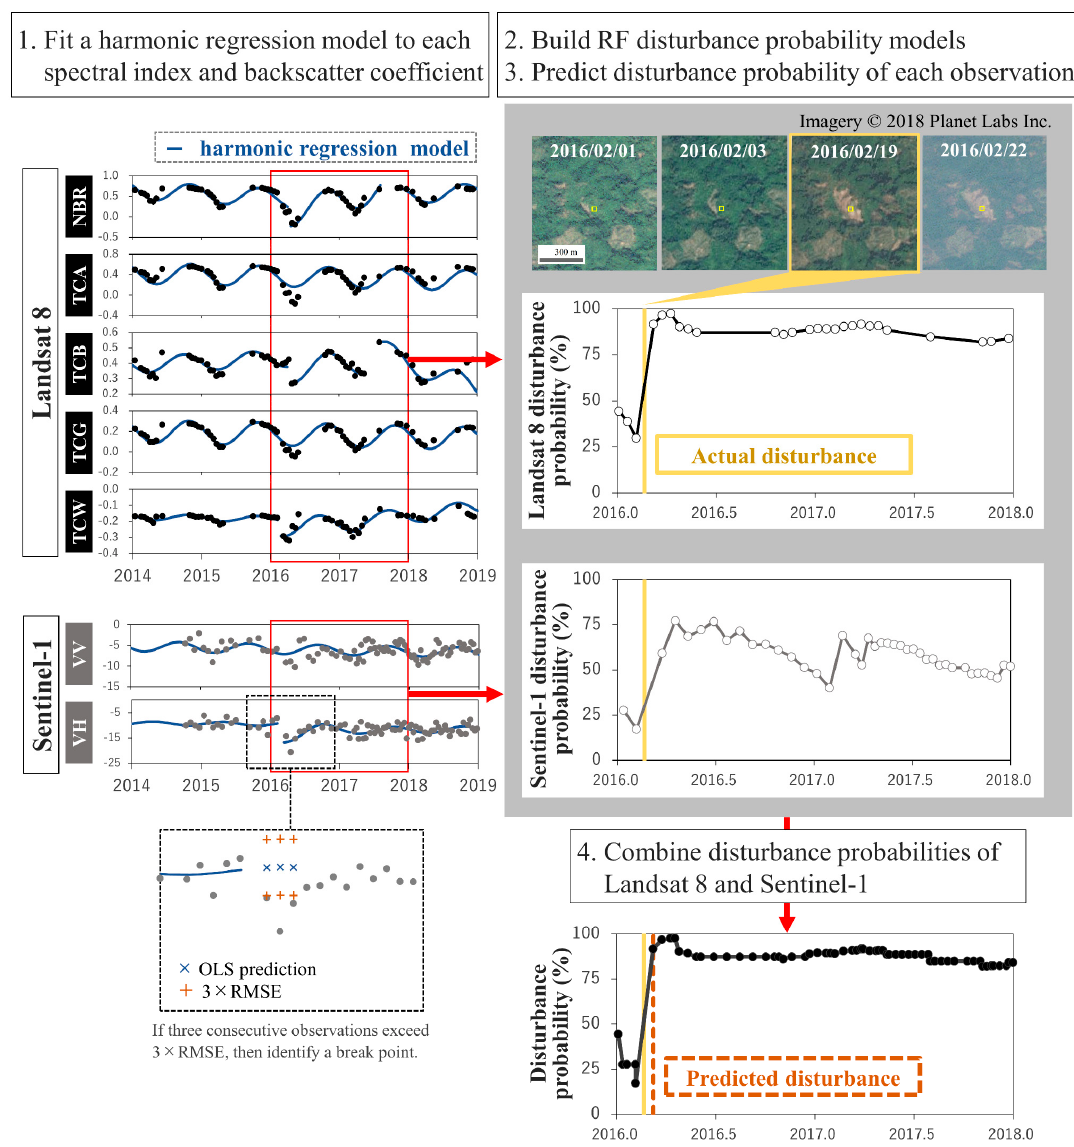
Figure 2. Schematic flow of overall analysis of disturbance detection. PlanetScope images from [57] were used for visualization.